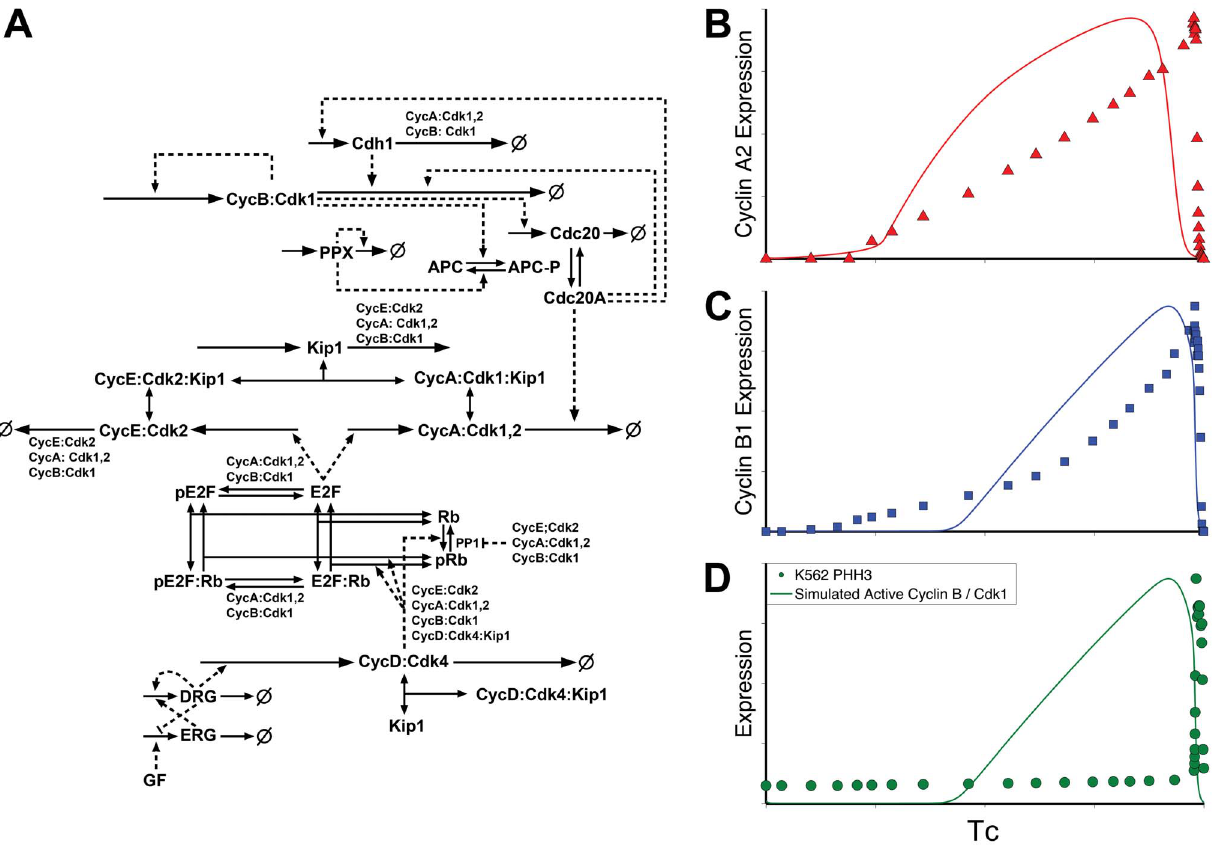
Figure 2. Model Schematic and comparison of model outputs to expression data I. A : schematic derived from the Conradie model [25]. Solid lines indicate chemical reactions and dashed lines indicate reaction modification (regulation). B, C, D : normalized comparison of model outputs with K562 data. Simulations were carried out using the published protocols and kinetic rate constants. Since antibodies do not discriminate between active/inactive, free/bound levels, total protein amounts (bound and free, inactive and active) from the model were compared to K562 measurements. As discussed in the text, PHH3 is used as a proxy for the timing of cyclin B/Cdk1 activity onset (identical to total cyclin B/Cdk1 expression in this model).